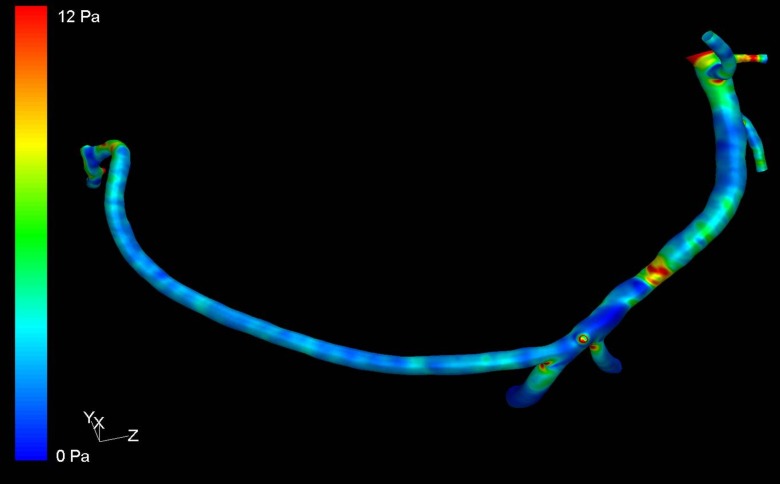
Color encoded illustration of endothelial shear stress (ESS) on a 3D model of a right coronary artery obtained by coronary computed tomography angiography.After segmentation side branches were cut 1–2 cm from the branching point. The volume mesh consisted of about 400,000 polyhedral cells. The Navier-Stokes equations were solved by the finite element method. The level of ESS increases from blue to red as shown in the color map on the left.